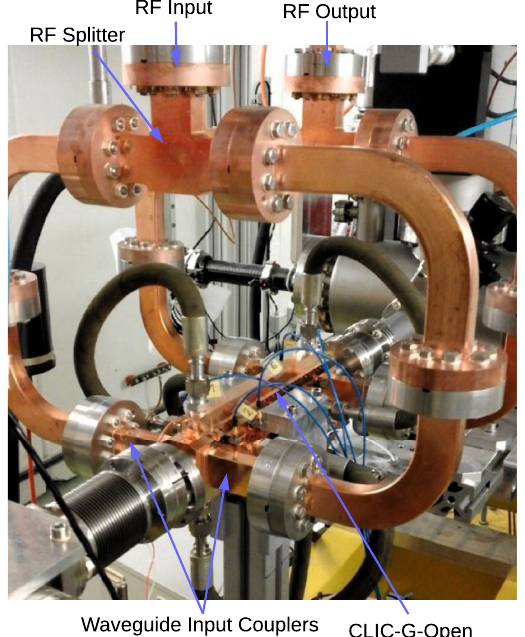
FIG. 10. Photos of the CLIC-G-OPEN after milling and after installation [11].